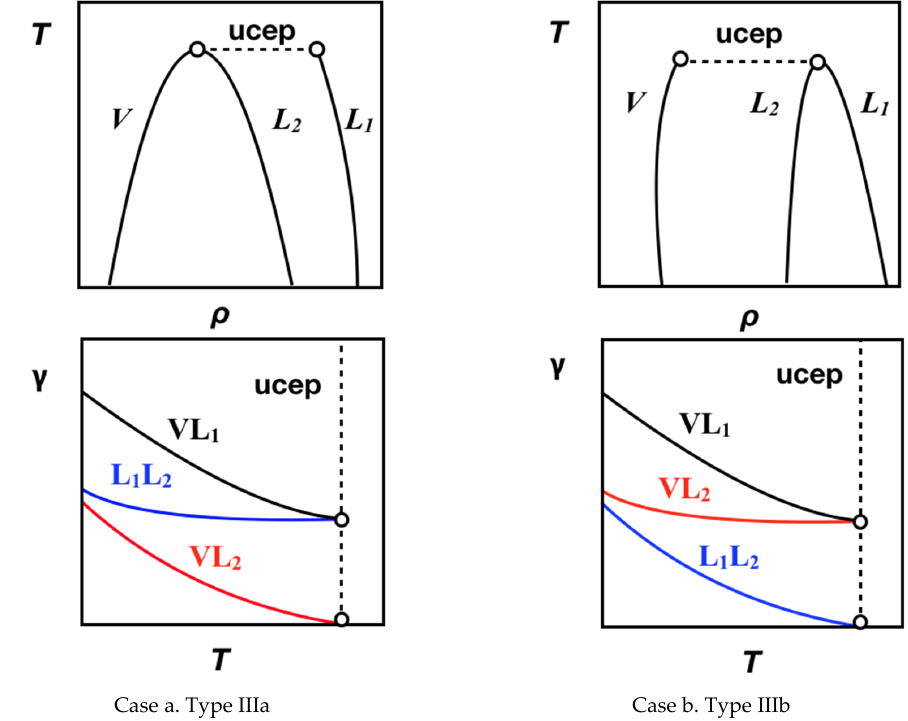
Figure 1. Schematic representation of Temperature, T – Density, ρ and Interfacial Tension, γ – Temperature, T diagrams for three-phase equilibrium in Type III binary mixture. Case a: Type IIIa; Case b. Type